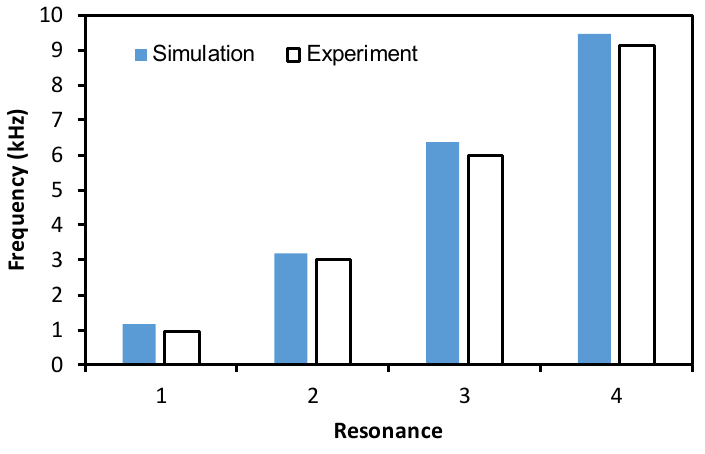
Figure 9. Resonant frequencies: simulation vs. experiment.